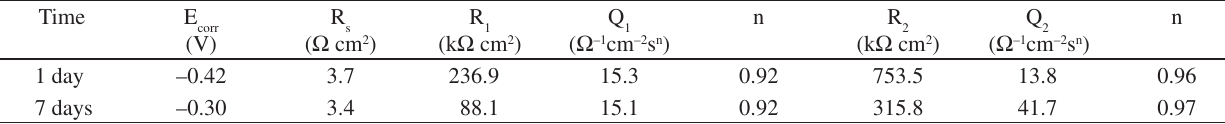
Table 2. Fitting parameters used to simulate the EIS of Ti6Al4V in citrate buffer at pH7.6 Time